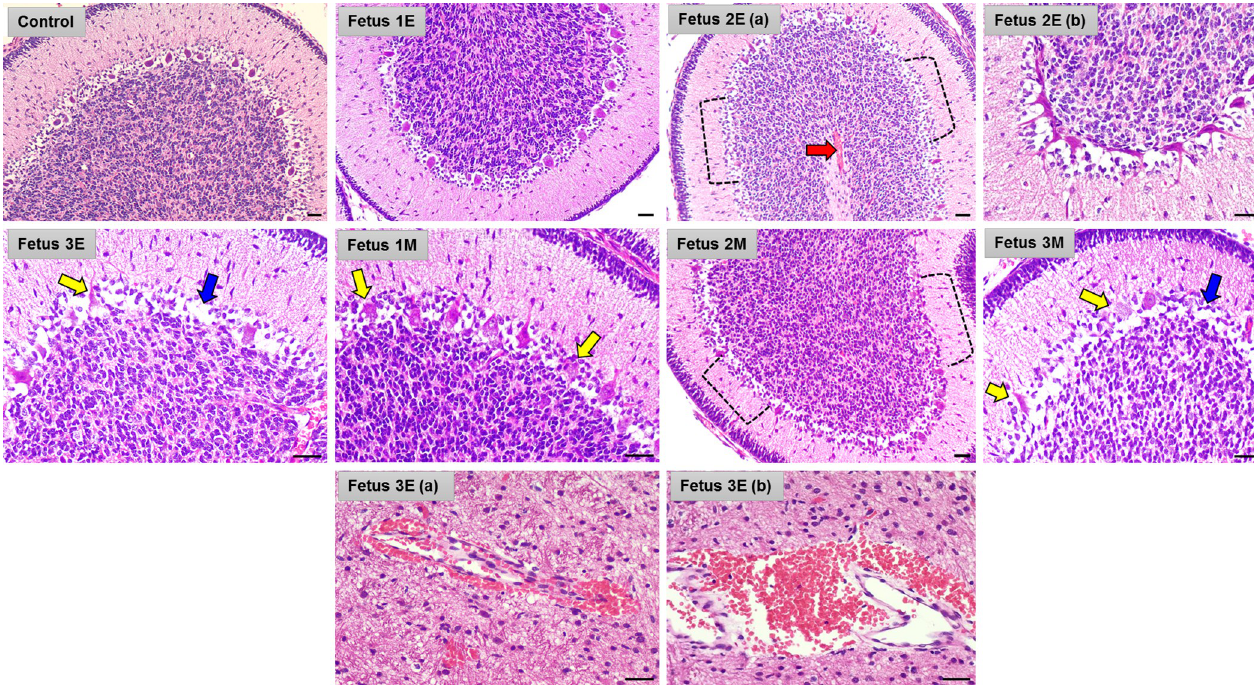
Fig 6. ZIKV inoculation results in structural cerebellar damage in early and mid-gestation infected fetal brain compared to the control. Representative images from H&E staining of control, early ( Fetus 1E, 2E, 3E ) and mid-gestation ( Fetus 1M, 2M, 3M ) cerebellum showing damaged and abnormal Purkinje cells in the ganglionic layer as marked by the yellow arrows whereas the blue arrows mark empty areas lacking Purkinje cells. The red arrow marks focal hemorrhage in the white matter of Fetus 2E cerebellum. In Fetus 2E (a) and Fetus 2M, the black dotted brackets highlight large areas in the ganglionic layer of the cerebellum lacking Purkinje cells. Fetus 3E (a and b) show large hemorrhagic areas in the cerebellar white matter. (Scale bar = 100 μ m).